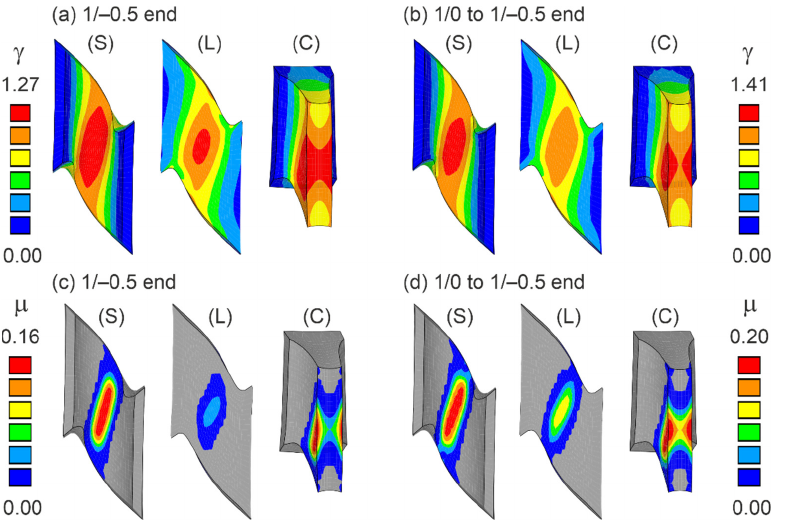
Figure 7. Spatial distribution of equivalent plastic strain γ and equivalent damage strain µ on the surface (S), in the longitudinal section (L) and the cross section (C) of a notch for load cases 1/ − 0.5 ( a , c ) and 1/0 to 1/ − 0.5 ( b , d ).